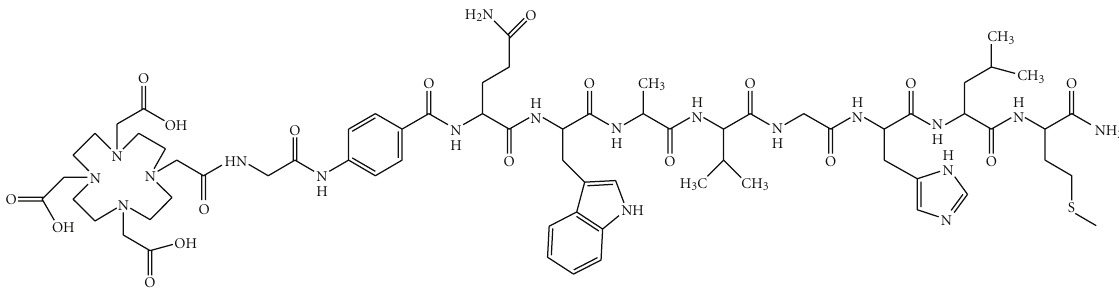
Figure 1: Representative structure of